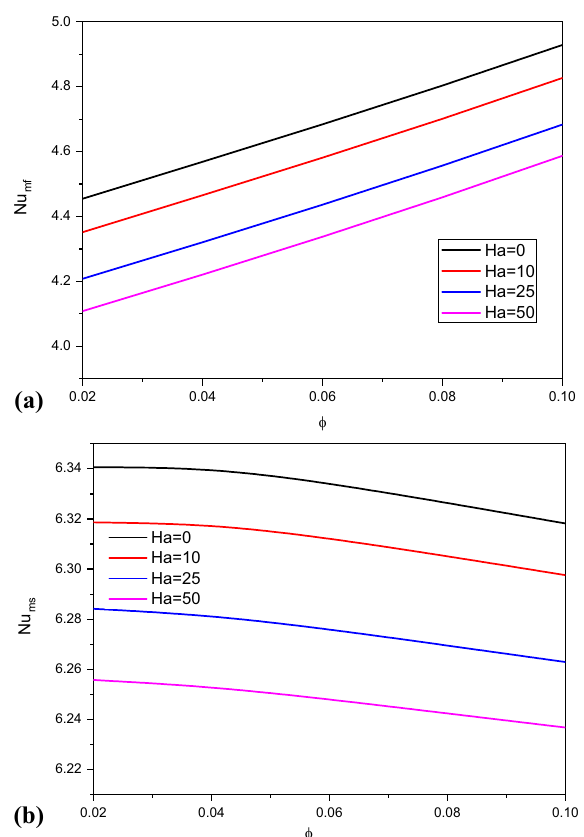
Figure 12. Profiles of Nu fs along the heat source below the changes on the Hartmann number Ha for hybrid nanofluid at φ Cu = φ TiO 2 = φ/ 2, φ = 0.05, B = 0.5, Q = 1, R d = 0.5, Da = 10 k fs = 1, D = 0.5, k r = 1, H ∗ = 10.